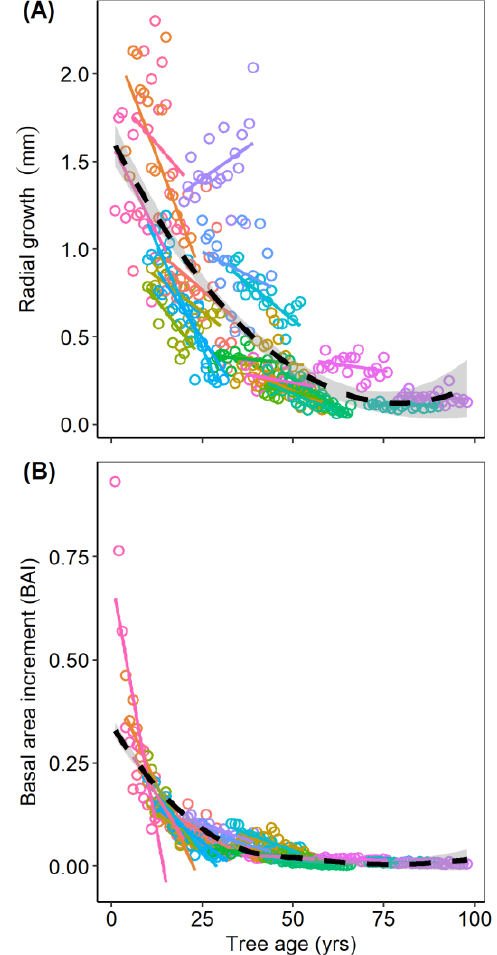
Figure 3. Annual radial growth (mm per year) ( A ) and annual basal-area increment growth (BAI; the proportion of a tree’s total cross-sectional area to date in mm 2 represented by annual ring area in mm 2 ) ( B ) as a function of tree age at the time of annual ring production. Different colored symbols and solid lines correspond to individual trees. The dashed line shows the population line of fit (using loess smoothing), with shading indicating the 95% confidence interval. The panels show untransformed data.